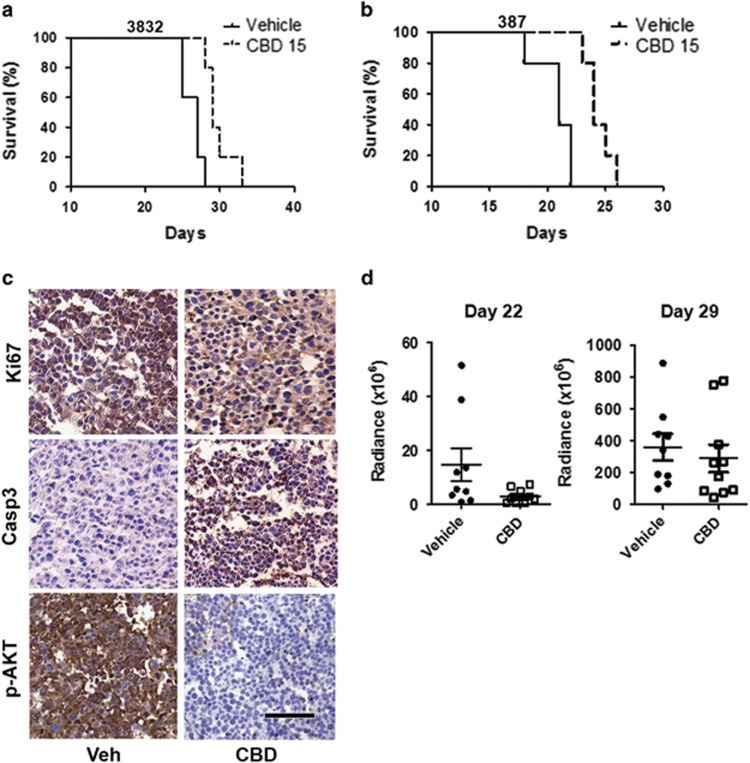
CBD prolongs survival mice bearing intracranial tumors derived from GSCs. Tumors were generated in female athymic nu/nu mice by the intracranial injection of 5 × 103 cells (a) 3832 or (b) 387 luciferase-labeled cells in 4 μl of media. Treatments were started at day 9 following BLI confirmation of tumor presence (using IVIS Lumina) and randomization of mice. Starting on day 9, 15 mg/kg of CBD was administered intraperitoneally 5 days a week until completion of the experiment. Animal health was monitored daily and when mice showed signs of disease progression, they were humanely killed in accordance with institutional IACUC guidelines. Survival data was evaluated using Kaplan–Meier curves and a long-rank Mantel–Cox test. (c) Representative tumor sections represent inhibition of Ki67 (upper panel) staining, upregulation of cleaved caspase-3 (middle panel) and inhibition of p-AKT (lower panel) induced by CBD. Tumors were harvested 25 days after tumor induction. Bar=200 μm. (d) BLI measurements demonstrate initial response to CBD (reduction of tumor size at day 22), followed by tumor resistance to treatment 1 week later (day 29)